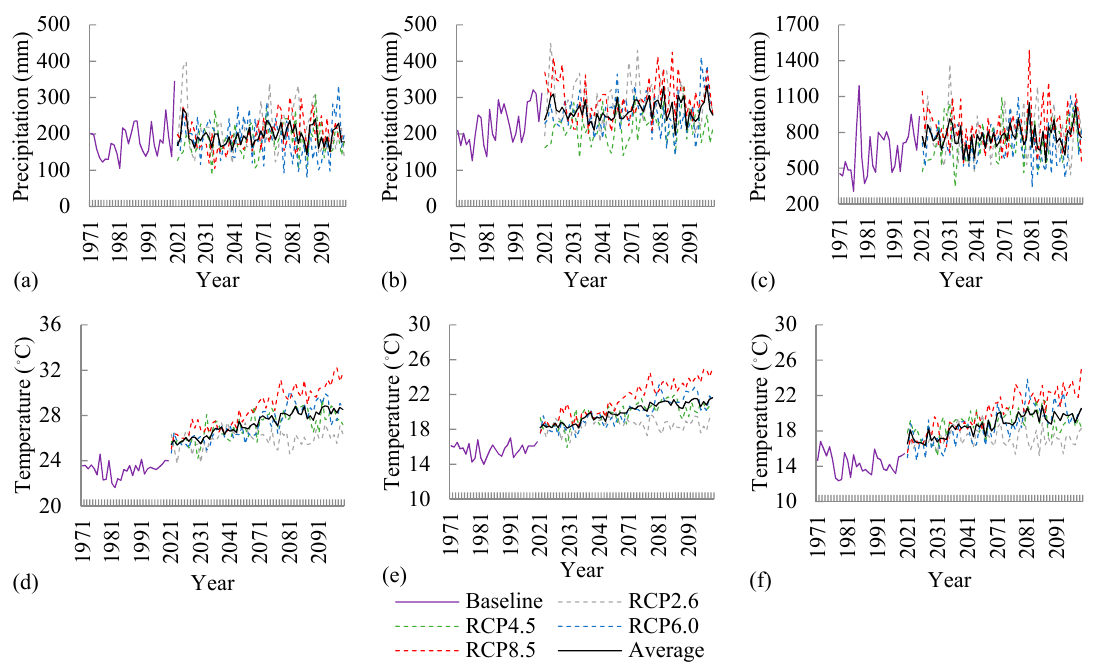
Figure 7. Precipitation and temperature in the fire season for three vegetation zones in the baseline, 2030s, and 2080s. ( a ) the precipitation during the fire season in the R1; ( b ) the precipitation during the fire season in the R2; ( c ) the precipitation during the fire season in the R3; ( d ) the mean daily maximum temperatures of the fire season in the R1; ( e ) the mean daily maximum temperatures of the fire season in the R2; ( f ) the mean daily maximum temperatures of the fire season in the R3.